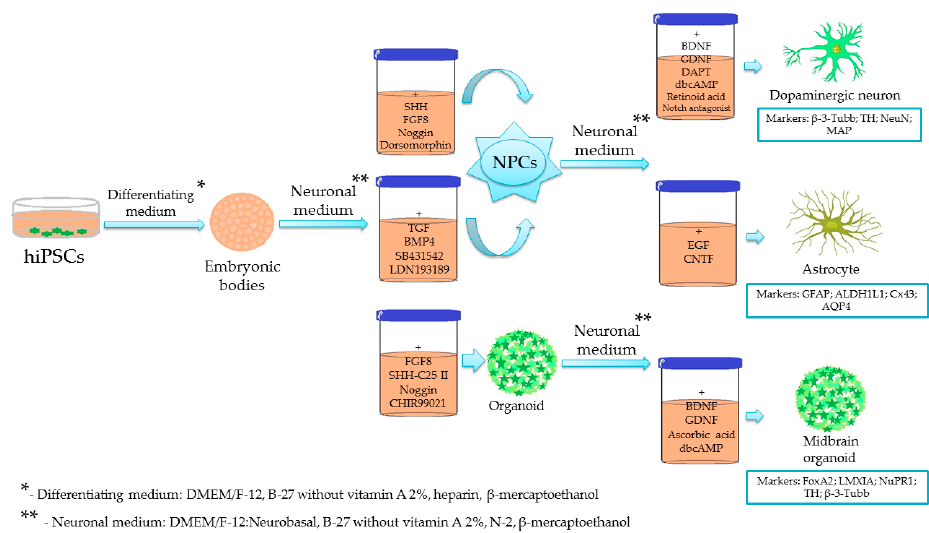
Figure 3. Summary of widely-used protocols for the generation of iPSC-derived midbrain cells and cerebral organoids. The scheme shows the main procedures aimed to establish the appropriate local microenvironment for the in vitro differentiation of cells toward midbrain neurons, glia, and multicellular structures (cerebral organoids).